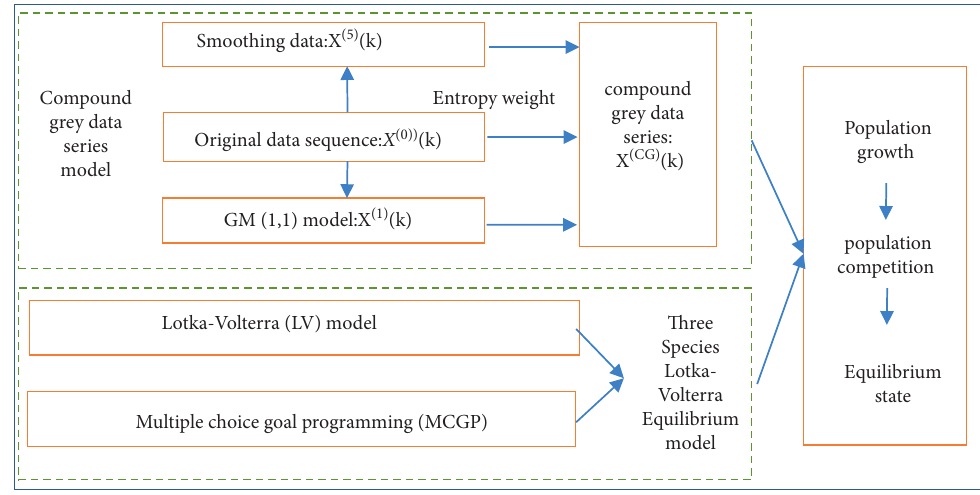
Figure 1: Research